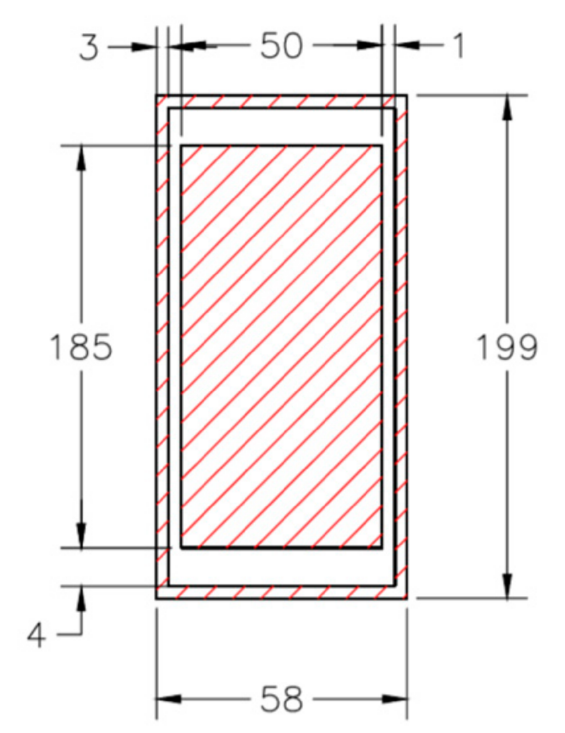
Figure 2. Illustration of the overall dimensions of the stretcher (in